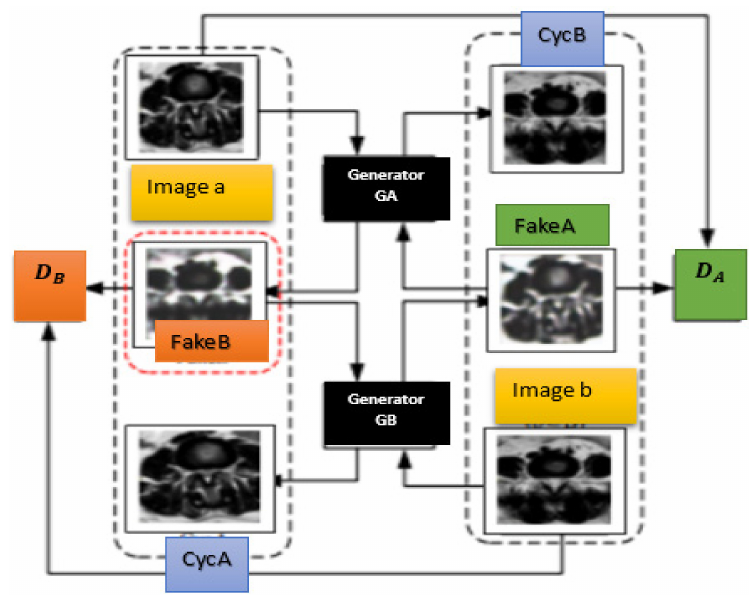
Figure 2. CycleGAN